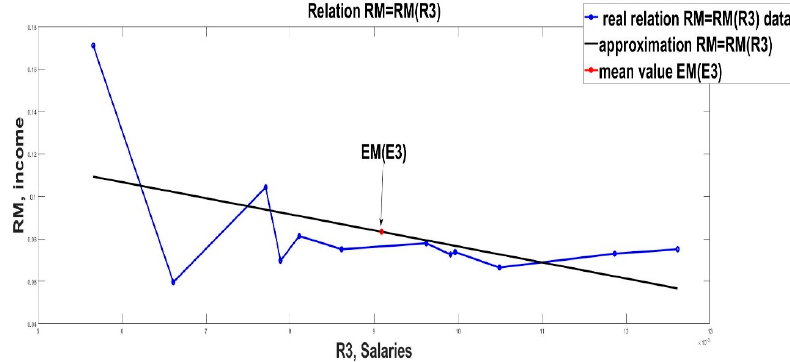
Figure 4. Linear approximation of income R M from R 3 (salaries). Table 5. Solutions of the portfolio problem (18) and constraint